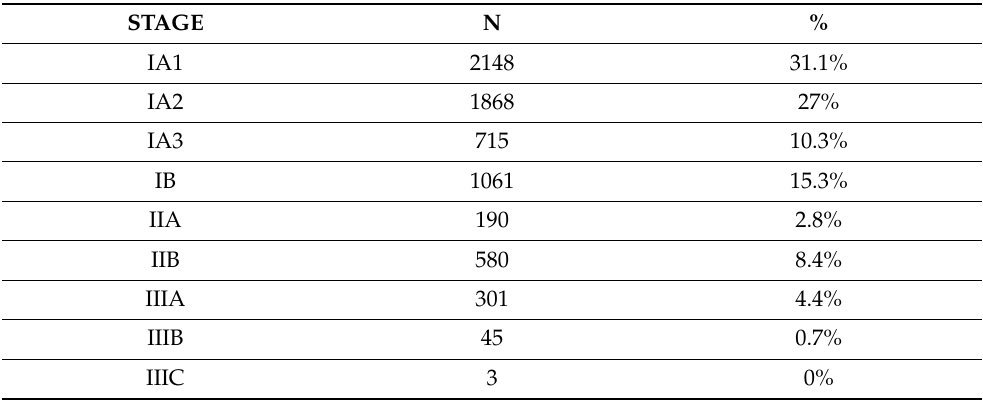
Table 4. Clinical staging (6911 Path 0–Path 5 patients) according to the “International Association for the study of Lung Cancer—Stage Grouping for the 8th Edition of the TNM Classification for Lung Cancer”